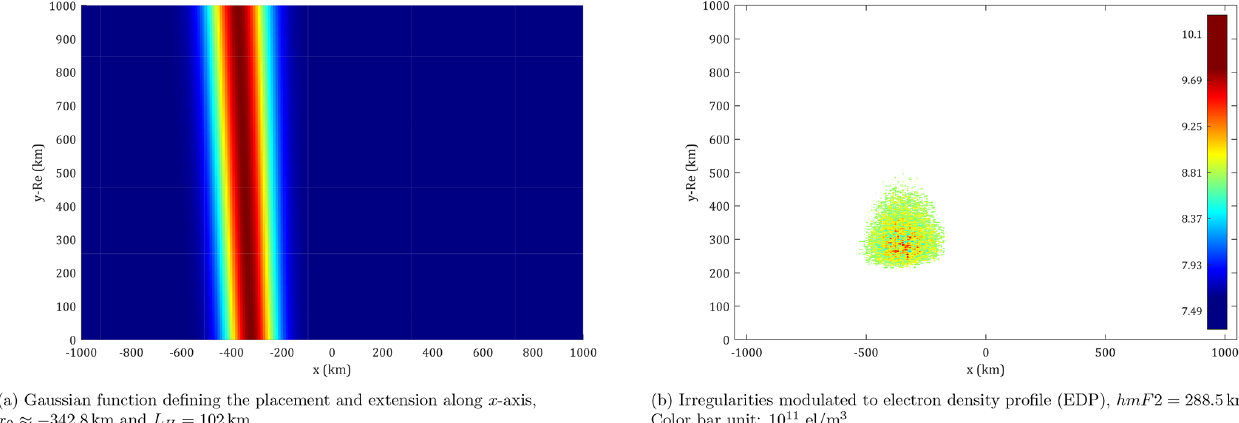
Figure 4. Modelling of the irregularity region used during the forward propagation in simulations. (a) Gaussian envelope defined by